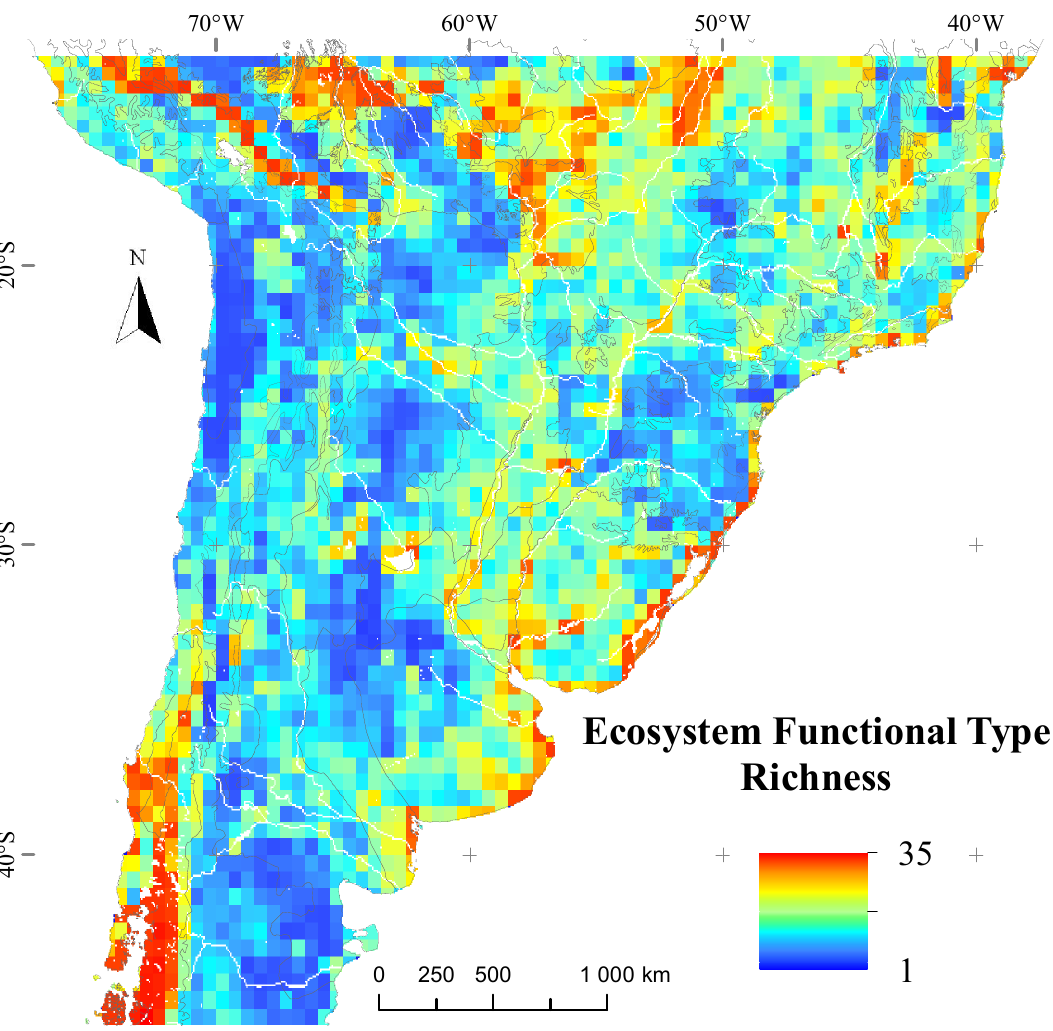
Figure 4. Spatial patterns of Ecosystem Functional Types richness in temperate South America. The map shows the number of EFTs in each 0.05° × 0.05° grid cell. Rivers and water bodies are shown in white and ecoregion borders in